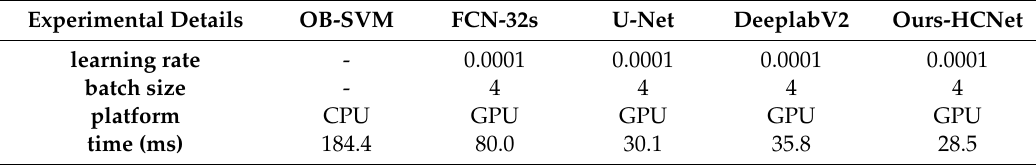
Table 3. Experiments setup and computational complexity using di ff erent classification